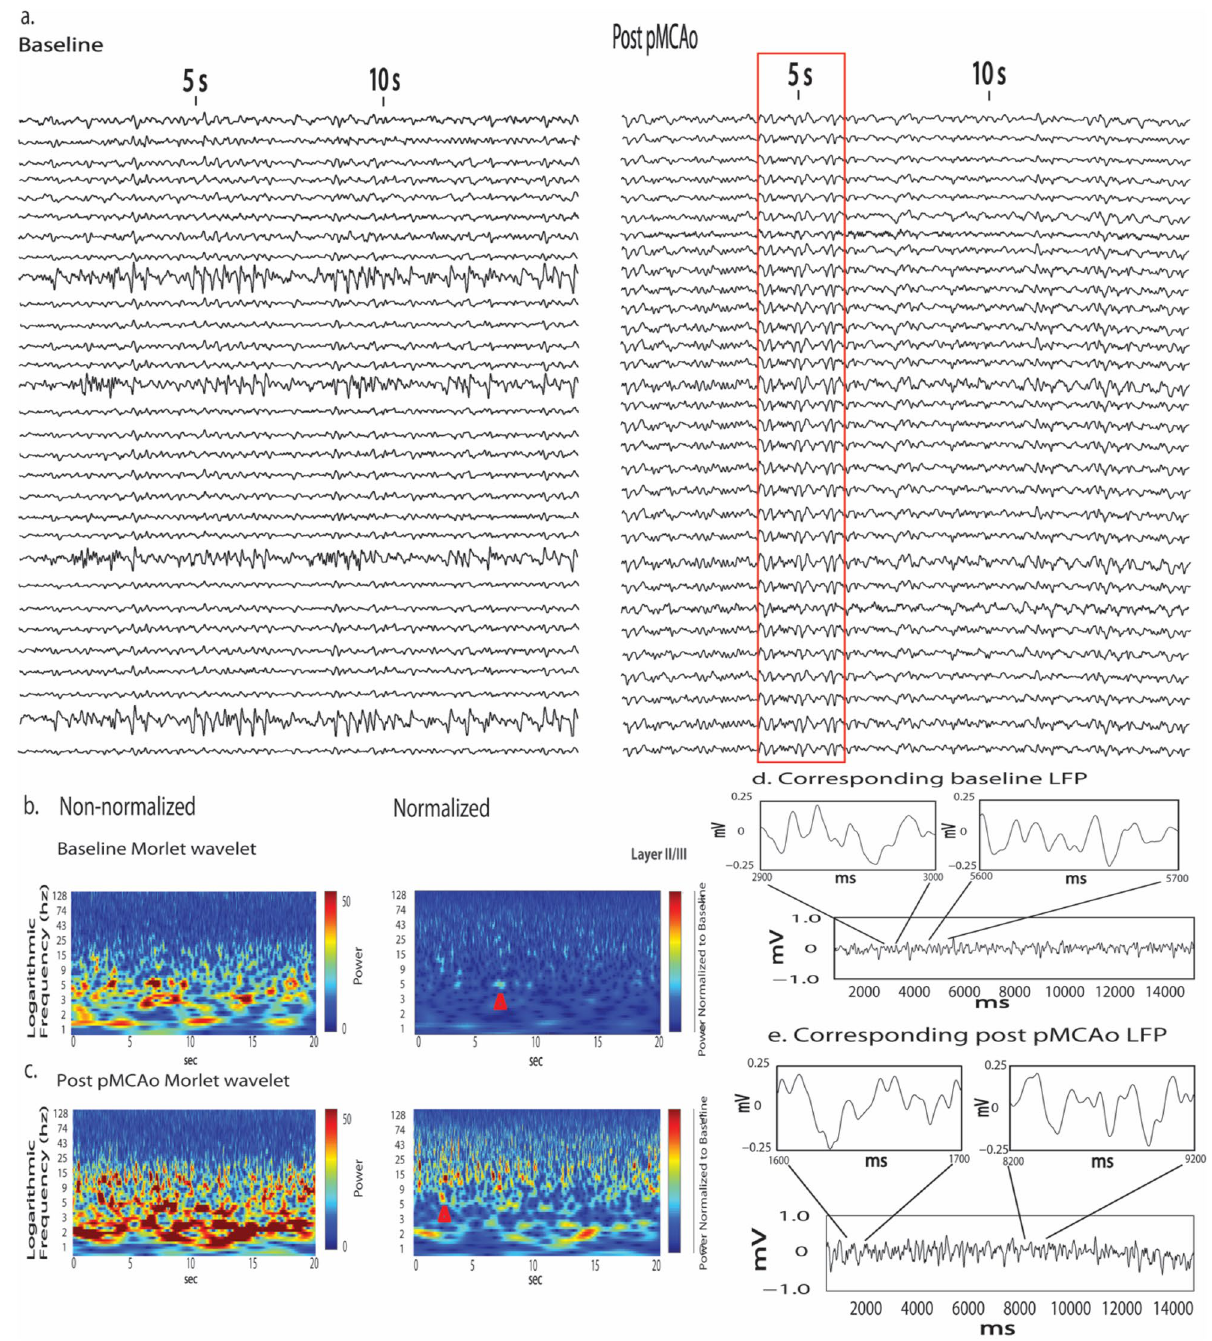
Figure 6. Temporally discrete increases in power (multi-frequency power bursts) are more frequent and are consistently above baseline post pMCAo. ( a ) Representative LFP traces from directly before and within 1 min after pMCAo demonstrate increased similarity between electrodes in spatiotemporal neuronal activity patterns after ischemic onset. As illustrated by the red box, LFP recordings across all electrodes were noticeably spatial and temporally similar post pMCAo at timepoints when multi-frequency power bursts were also observed ( a , red box). ( b–e ) Representative power spectrum across logarithmically scaled frequencies of the same LFP time series shown for the first electrode in a. Left panels of ( b ) and ( c ) represent the power spectrum in a Layer 2/3 recording directly before ( b ) and within one minute after ( c ) pMCAo (electrode 1 in a ). Right panels of ( b ) and ( c ) show baseline (b) and post pMCAo ( c ) samples after normalization to the z-score of the total baseline. ( d , e ) Isolated (above) traces depict time points identified within a multi-frequency power burst and shown by the red arrow in ( b ) and ( c )